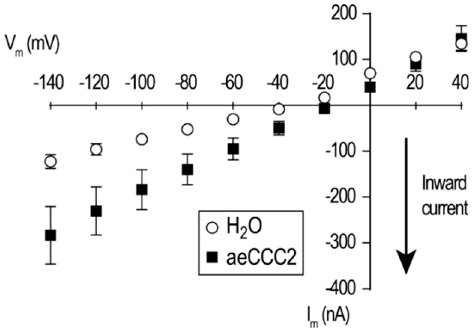
Figure 4. The mean current–voltage (I–V) relationships of Xenopus oocytes in ND96 2–3 days after injection with aeCCC2 cRNA (80 ng) or H 2 O (80 nL) as determined by TEVC. Values are means ± SEM; N = 3 oocytes each for aeCCC2 and H 2 O.